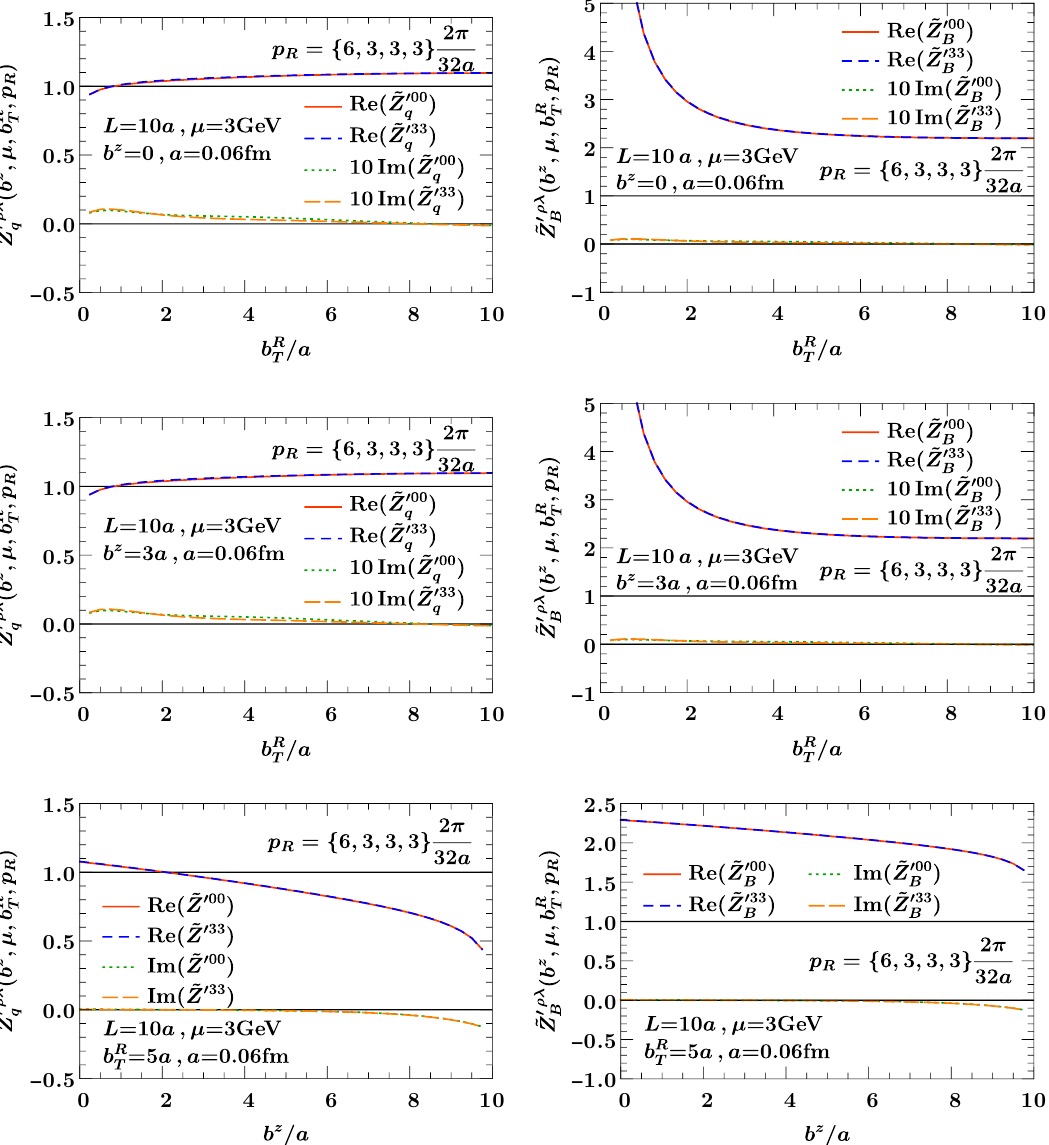
Figure 4. One-loop conversion factors ~ Z 0 from the RI 0 /MOM scheme to the MS scheme for the quasi-TMDPDF (left) and the quasi-beam function (right), as a function of b T =a for b z = 0 (top), as a function of b T =a for b z = 3 a (middle) and as a function of b z =a for b T = 5 a